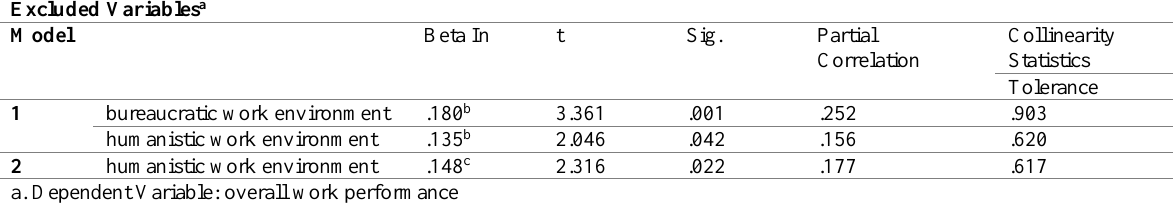
Table 13(d): Collinearity